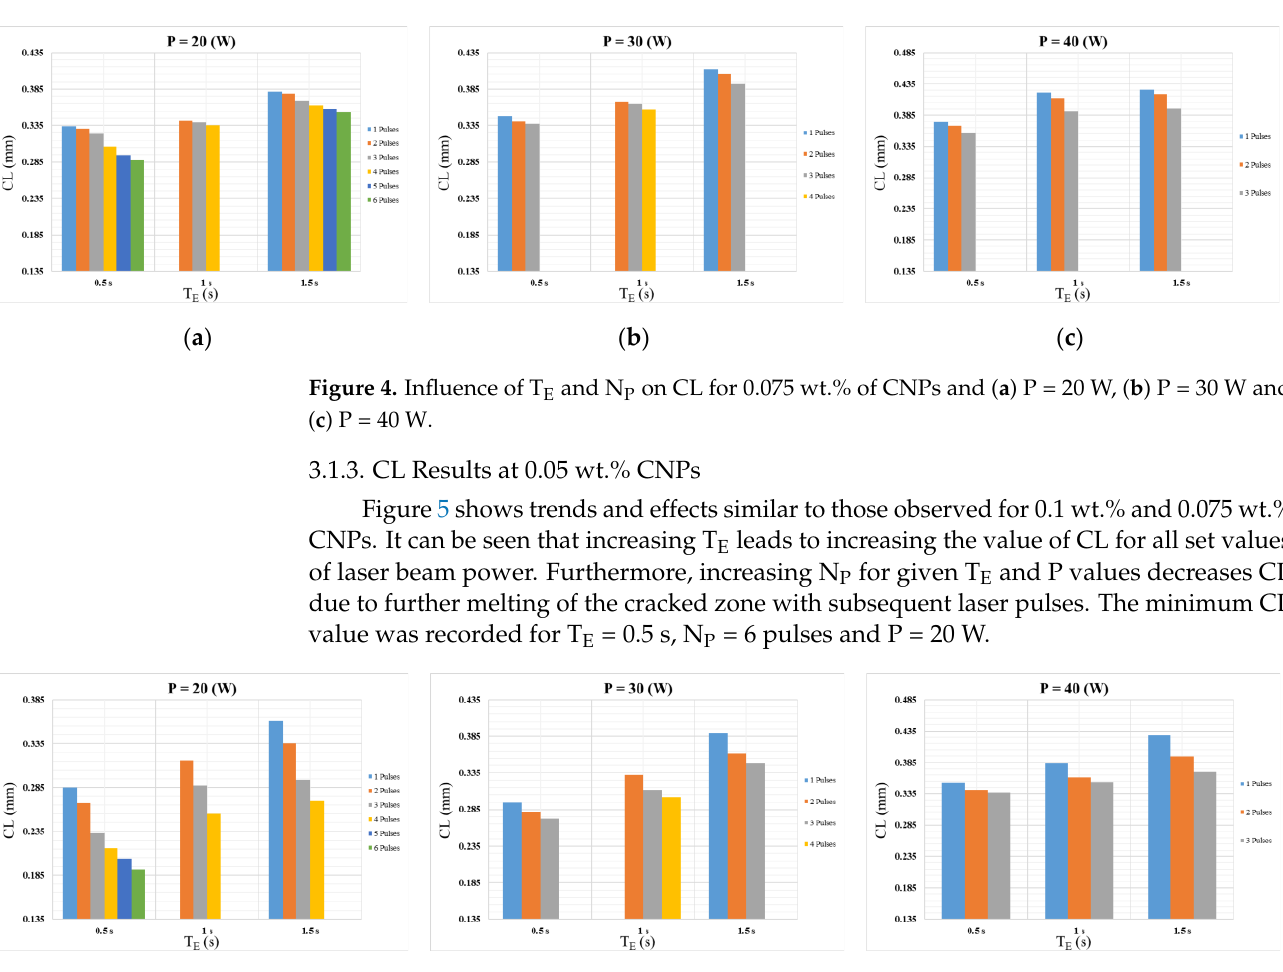
Figure 3. Influence of T E and N P on CL for 0.1 wt.% of CNPs and ( a ) P = 20 W, ( b ) P = 30 W and ( c ) P = 40 W.